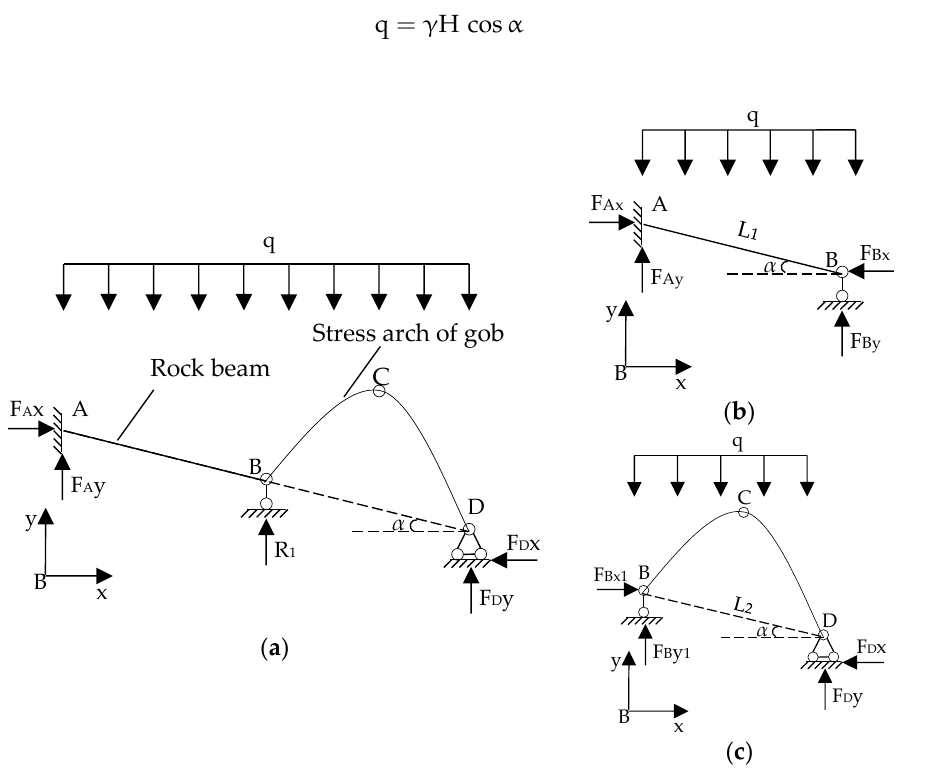
Figure 3. Roof inclined fracture structure of short width working face. ( a ) Mechanical model of rock beam multi-articulated structure; ( b ) rock beam structure isolator; ( c ) multi-articulated structure isolator.